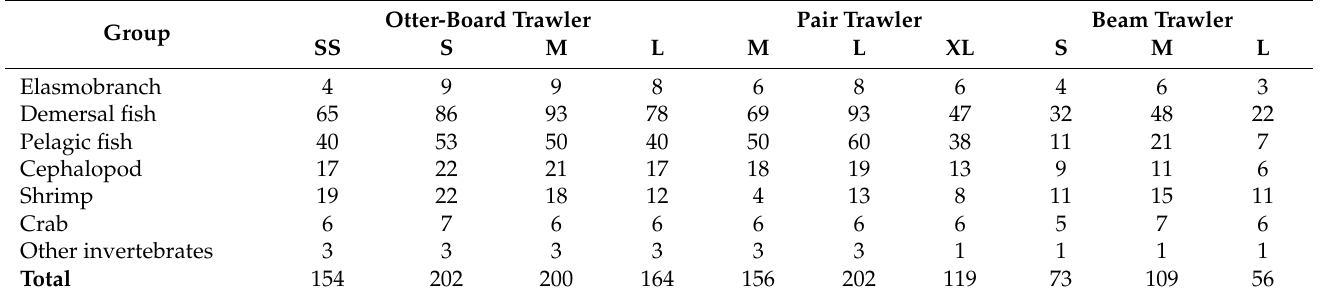
Table 2. Number of species of fishes and other aquatic animals caught by trawl fisheries in the Gulf of Thailand and used in this